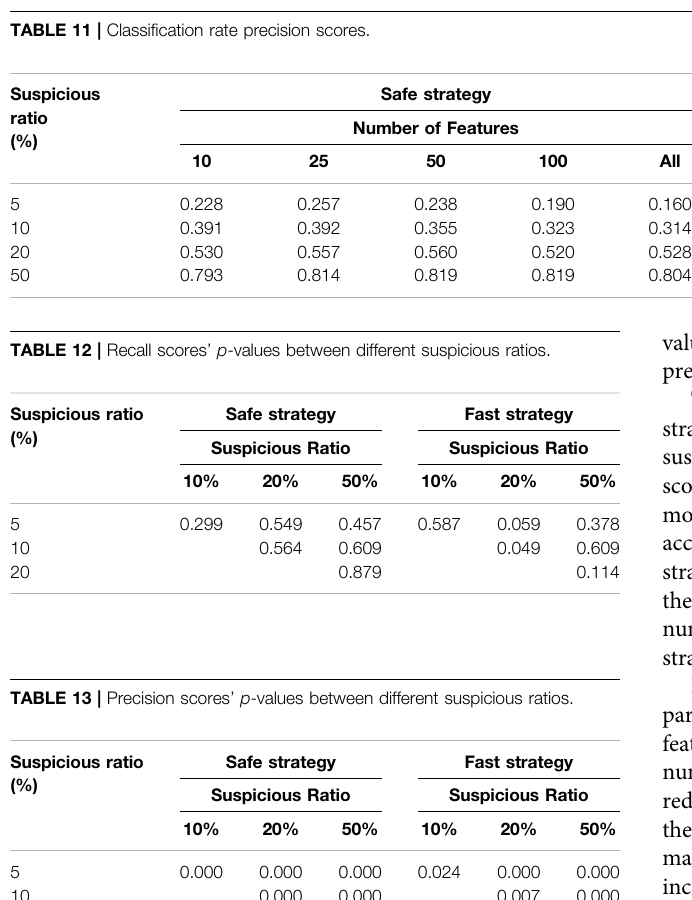
TABLE 11 | Classi fi cation rate precision scores.